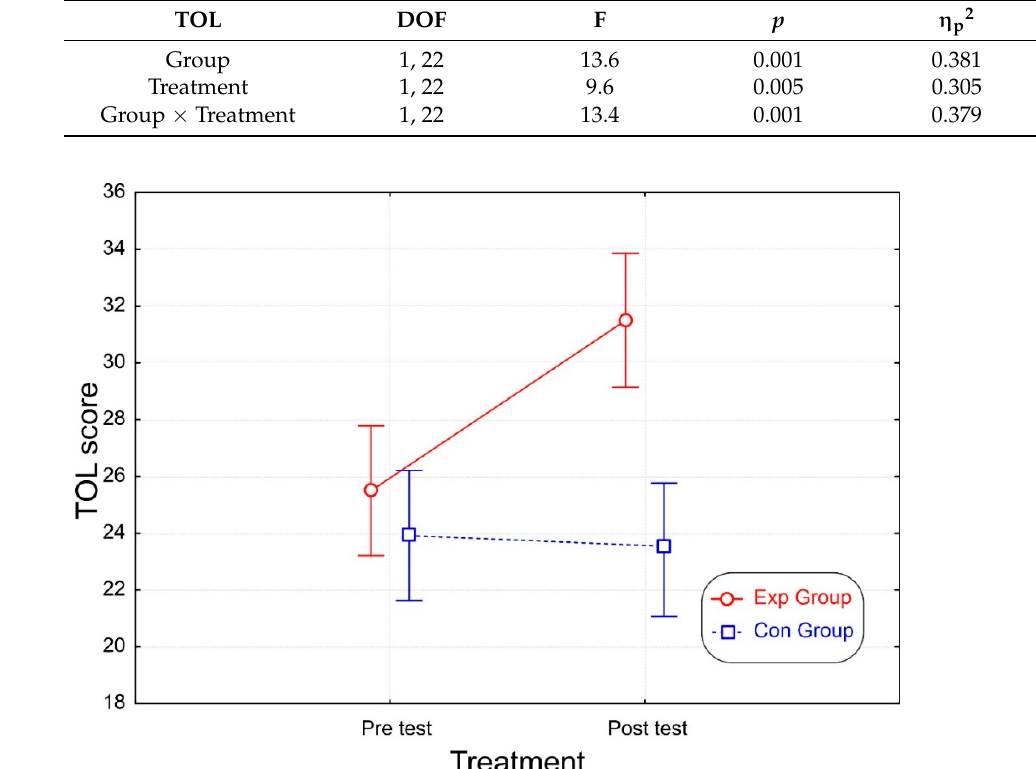
Table 1. ANOVA data for the TOL total score. Degrees of freedom (DOF).